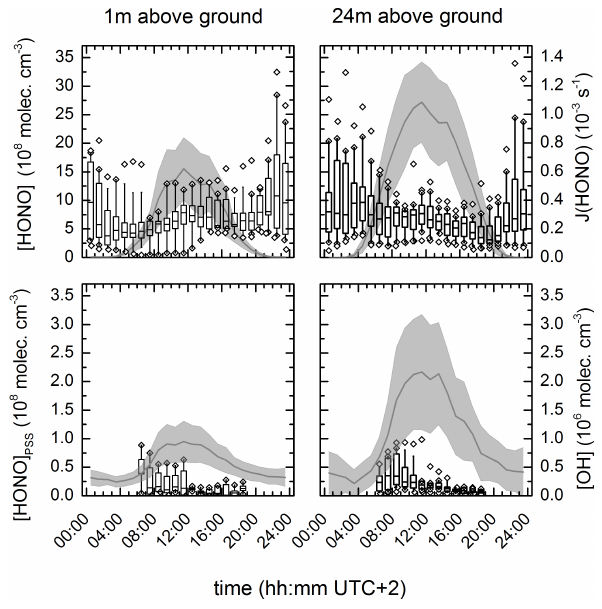
Figure 3. Upper panels show box plots of the diel cycle of HONO measured at 1m and 24m respectively and the average correspond- ing J( HONO ) with standard deviation (grey shaded line). Lower panels show box plots for the calculated PSS concentration of HONO for the heights of 1m and 24m respectively during day- time (lifetime of HONO below 4h) where PSS is possibly attained. Additionally, the average concentration of OH with standard devi- ation (grey shaded line) for the two respective heights is presented. The boxes represent the 25 to 75 percentile, the line within the box is the median, the bars show the 10 to 90 percentile and outliers are marked as open